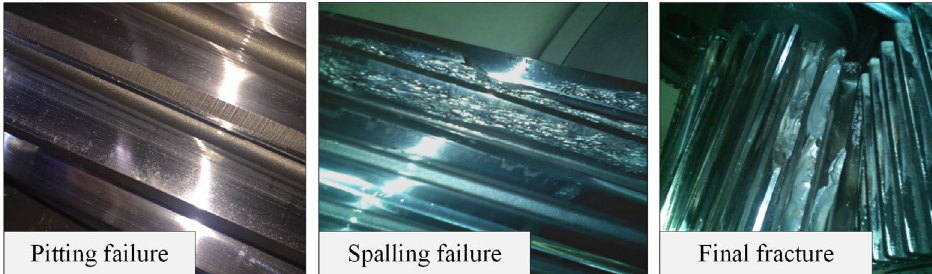
Fig. 1 Pitting and deep spalling failure, and final fracture of wind turbine